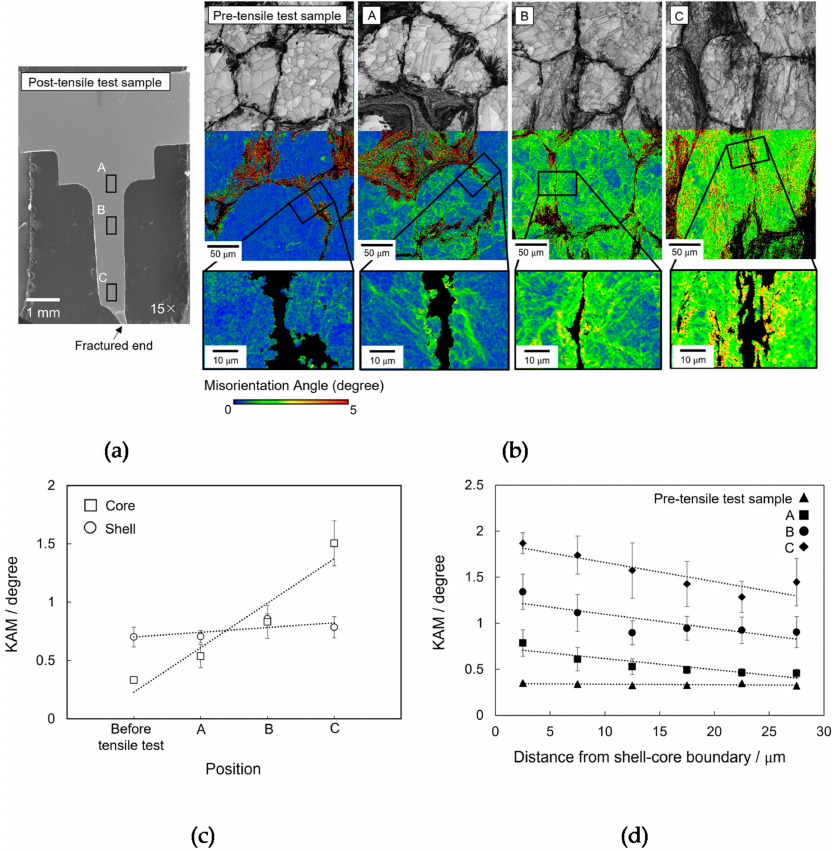
Figure 2. ( a ) SEM micrograph showing the different investigated positions of the post-tensile test sample (labeled A, B and C). ( b ) Variation in the IQ (top half) and kernel average misorientation (KAM) (bottom half) with a 0.5 µ m step size of the pre-tensile test sample and of the post-tensile test sample at the different position shown in ( a ). Magnified KAM images with the same step size of the marked boxes near the shell–core boundary are also shown, in which the shell region is not indexed (individual grains are not shown for clarity owing to the fine and complicated structure). ( c ) Average KAM of the shell and core regions in the positions shown in ( b ). ( d ) Spatial distribution of the KAM for the four positions plotted as a function of the distance from the shell–core boundary toward the grain